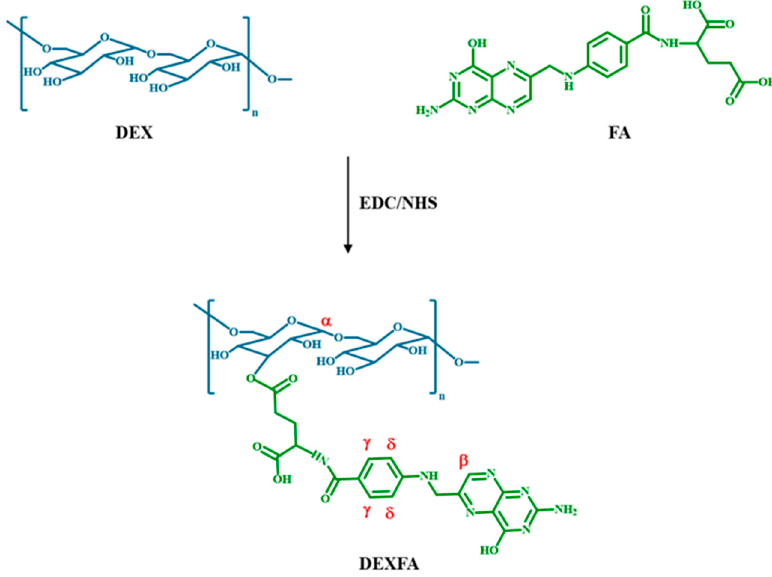
Figure 3. Synthesis of DEXFA conjugate.